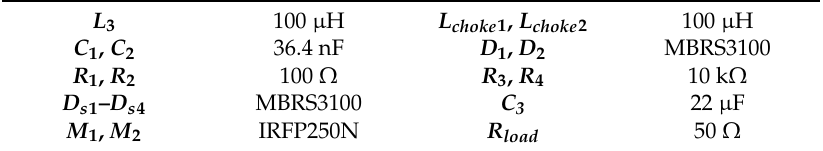
Table 1. Parameters and components of a traditional circuit.